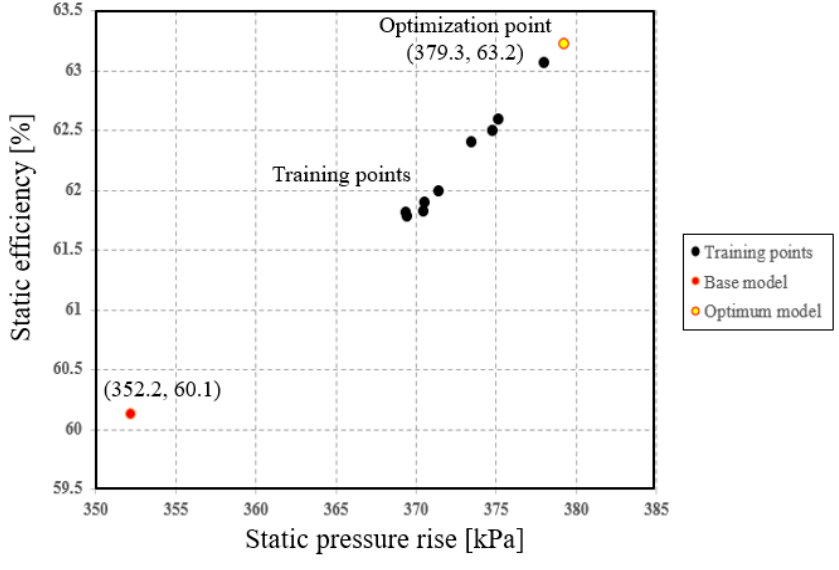
Figure 9. Optimal solution with the result of training points. Table 5. Results of the multi-objective optimization for the 2nd diffuser.